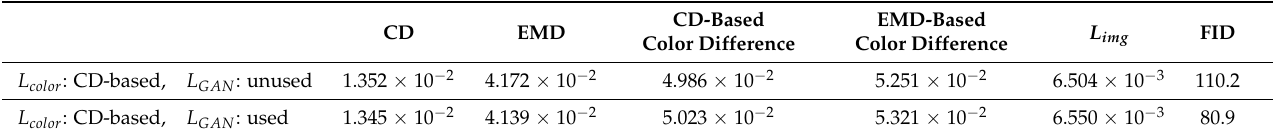
Table 2. Evaluation results of learning with the proposed network.